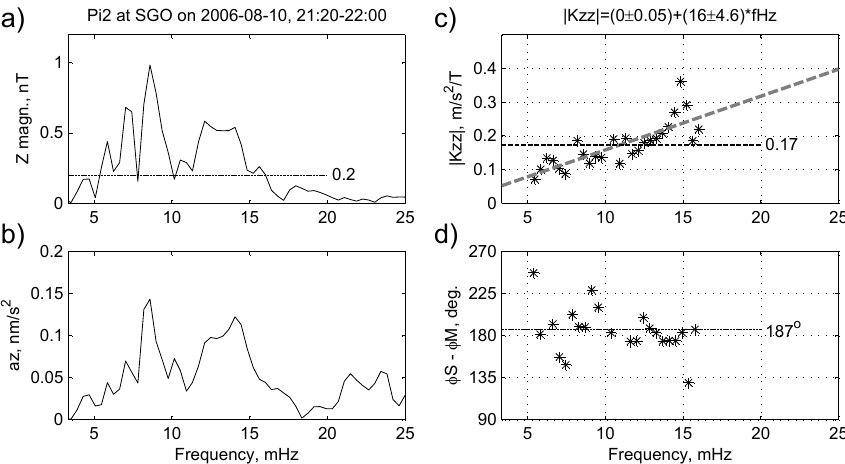
Fig. 5. (a) and (b) show amplitude spectra of the simultaneous magnetic and seismic acceleration signals, respectively; (c) shows the seismic- to-magnetic amplitude ratio ( K zz ), calculated for the frequencies at which amplitudes of magnetic signal exceed a noise level of 0.2nT; (d) shows the phase shift (near 180 ◦ ) between the seismic and magnetic